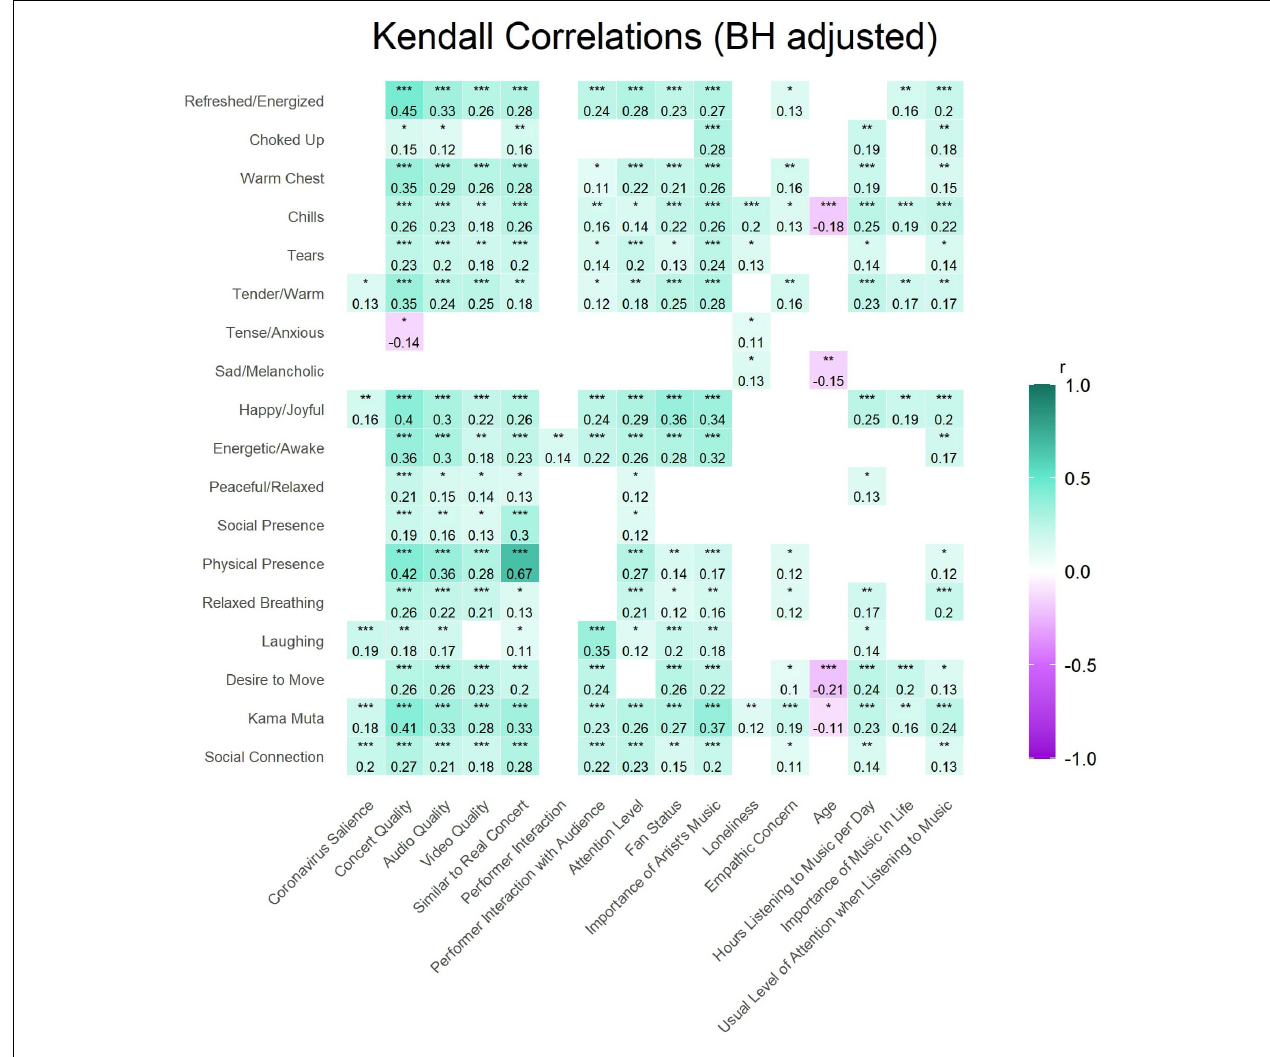
FIGURE 6 | Kendall correlations with BH adjustment between concert and personal characteristics ( x -axis) and outcomes of emotions and embodied reactions ( y -axis). Note that some of the measures within the measure of kama muta are displayed here on the y -axis to show the correlation between specific embodied reactions and the predictor variables (i.e., refreshed/energized, choked up, warm chest, chills, and